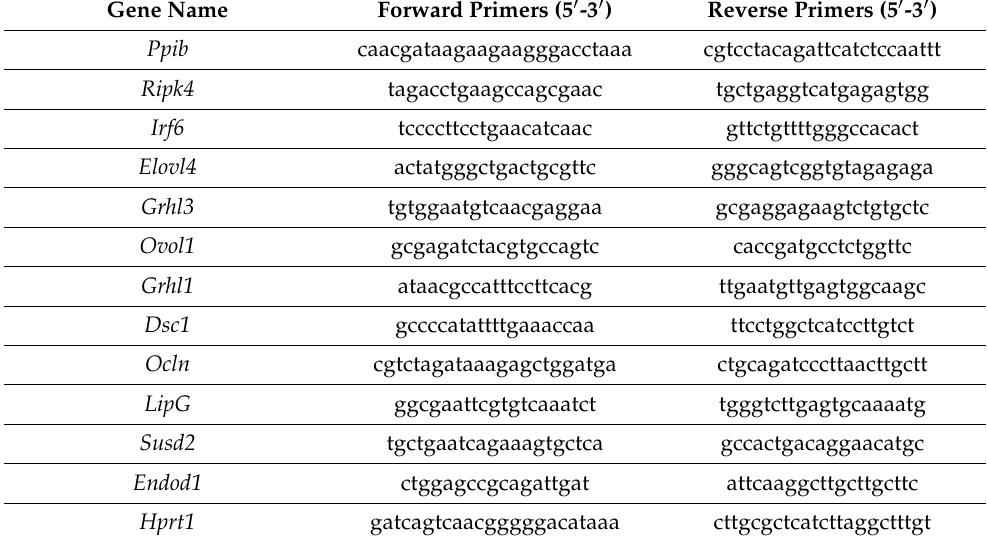
Table 1. List of primers used for qPCR